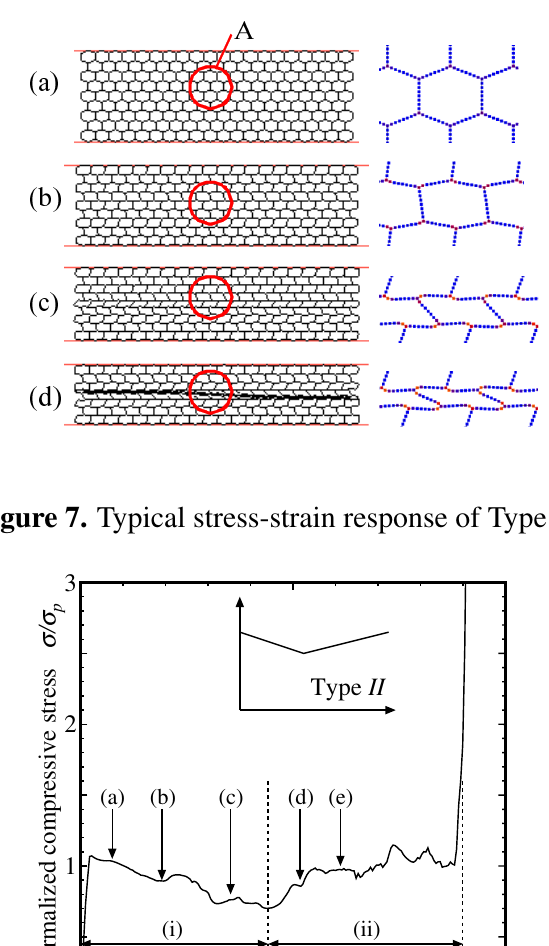
Figure 6. Deformation process of Type I honeycomb.